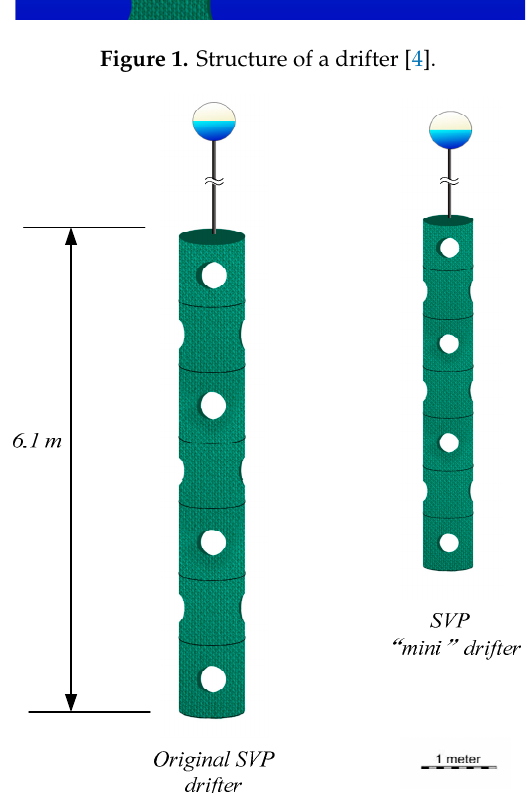
Figure 2. Schematic of two basic sizes of Surface Velocity Program (SVP) drifters [4].